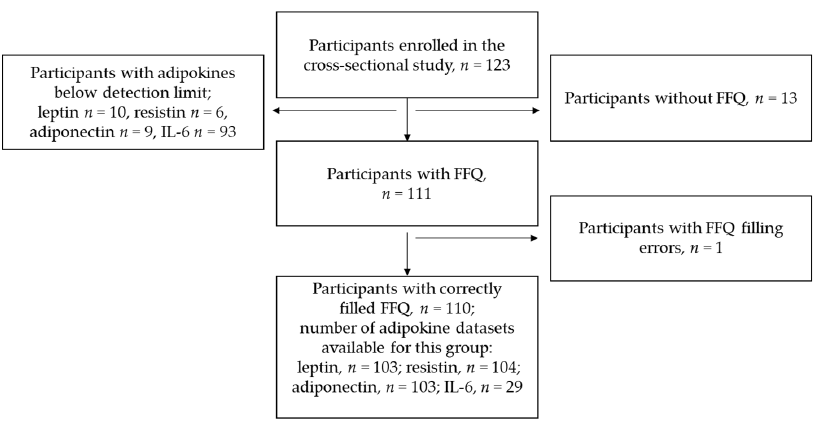
Figure 1. Flow chart of the sample included in the study process; FFQ, food frequency questionnaire.